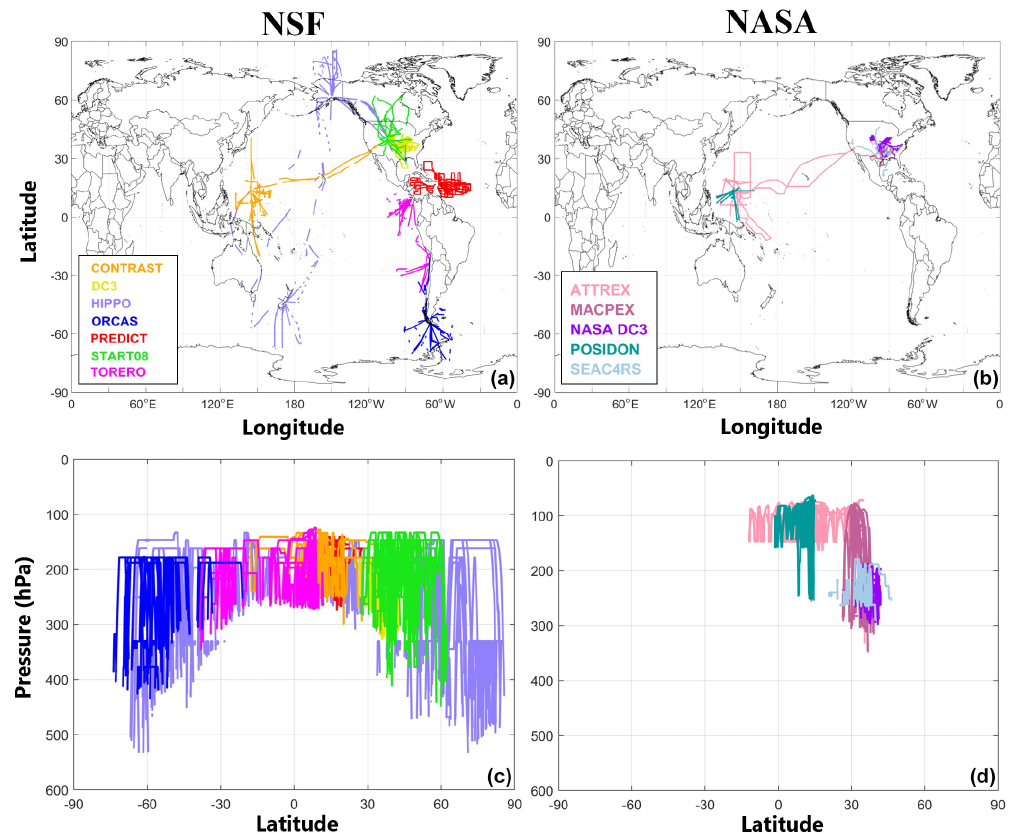
Figure 1. The flight tracks for (a) seven NSF flight campaigns and (b) five NASA campaigns. Panels (c) and (d) show the latitudinal cross-section of the NSF and NASA datasets, respectively. All flight tracks are restricted to temperatures ≤ − 40 ◦